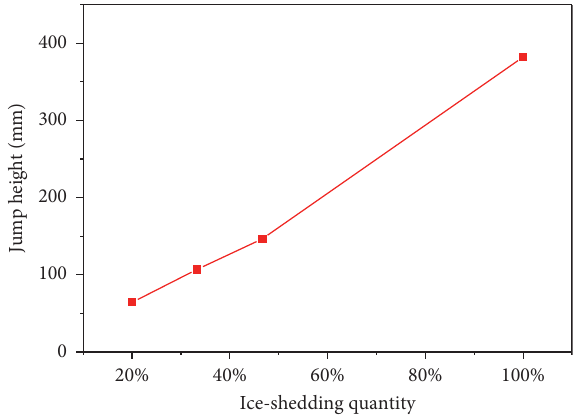
Figure 9: The variation of the jump height with ice-shedding quantity.